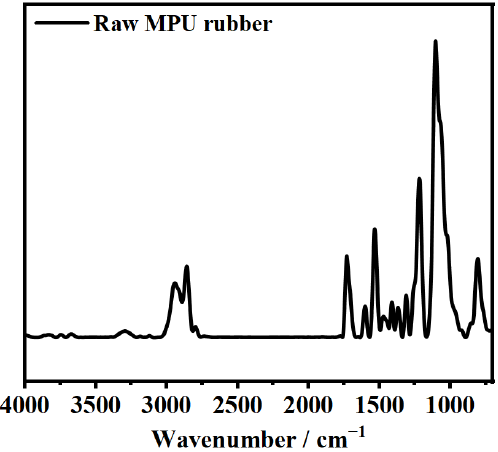
Figure 1. FTIR spectrum of raw MPU rubber.